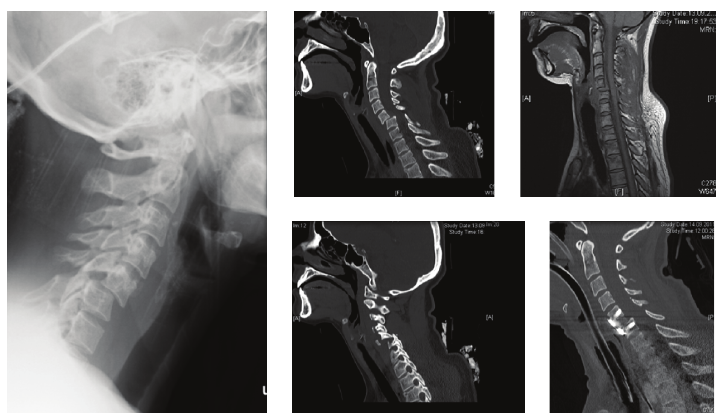
Figure 1: Conventional X-rays on admission showing fracture dislocation C4/5 (left); preoperative CT scan showing unilateral facet disloca- tion (middle); MRI after closed reduction (upper right); CT scan after anterior decompression and stabilization (lower